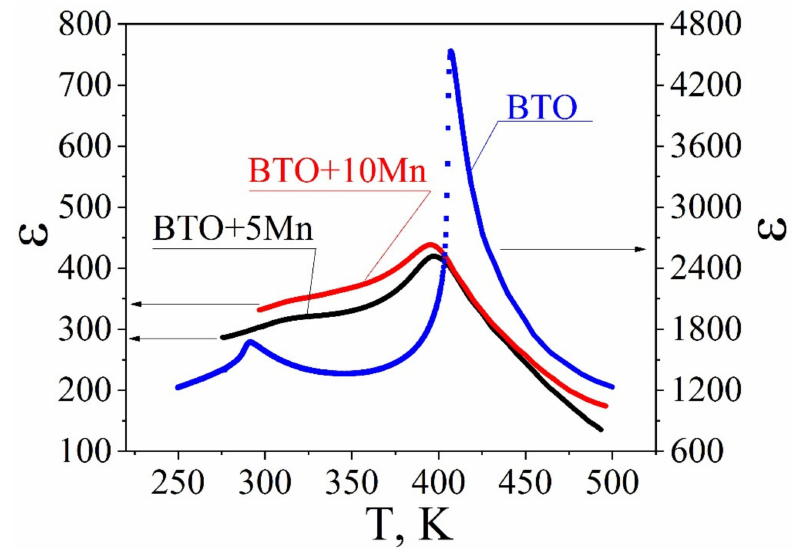
Figure 2. Temperature dependences of the e ff ective dielectric permittivity of pure BTO ceramics ( blue curve ) in comparison with that of Mn-doped samples. Much lower values of the permittivity in BTO-5Mn ( black curve ) and BTO-10Mn ( red curve ) are due to non-ferroelectric grains of the second